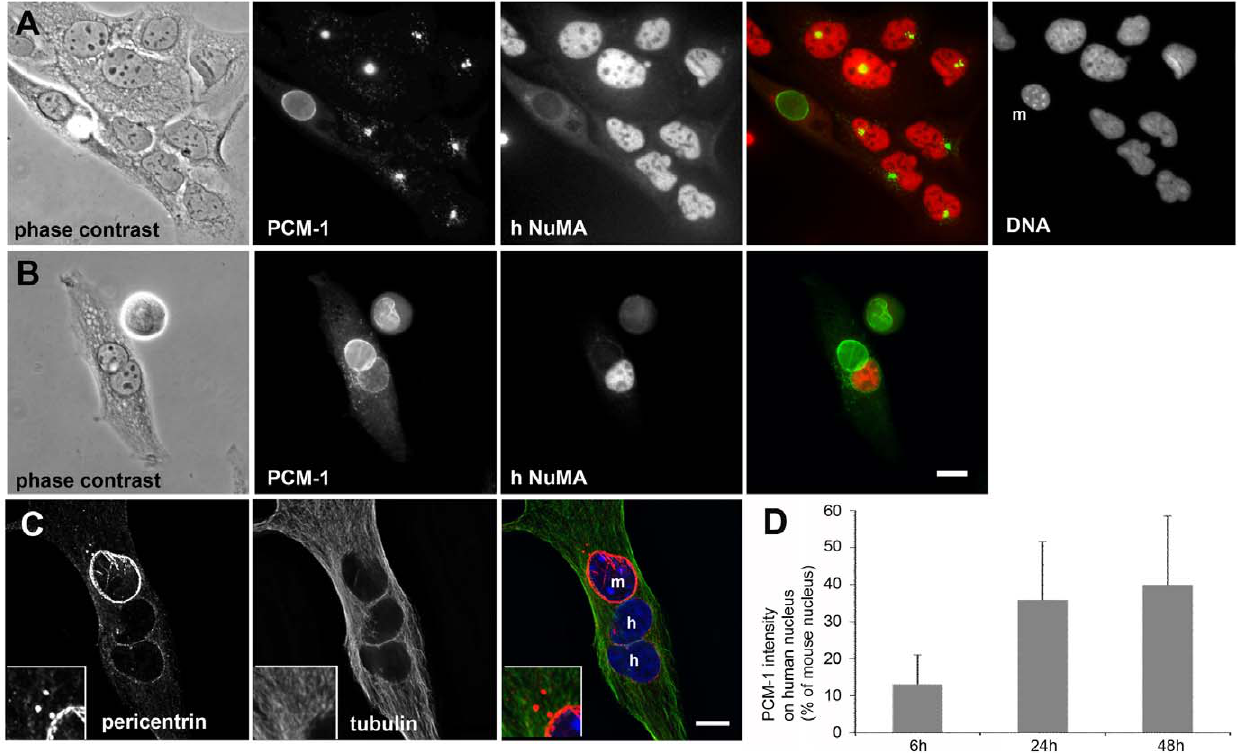
Figure 4. Centrosome proteins are recruited to the nuclear surface of non-muscle cells, after fusion with differentiated muscle cells. (A) Co-culture of H-2K b -tsA58 mouse muscle cells with human U2OS cells. Top left: phase contrast; top middle: immunofluorescence of the centrosome protein PCM-1; top right: staining of the DNA with DAPI; bottom left: immunofluorescence of the human form of the nuclear protein NuMA; bottom right: merge of PCM-1 (green) and NuMA (red) staining. Note that NuMA staining is exclusively visible in nuclei of the human U2OS cells. Mouse nuclei (m) show characteristic condensation of heterochromatin in discrete nucleoplasmic punctuate staining that is absent from the surrounding human nuclei. (B) Heterokaryon, formed by fusion of a human U2OS cell with a mouse H-2K b -tsA58 cell. A cell is shown at 48 hours after induction of fusion with polyethylene glycol. Staining and microscopy as in (A). The human nucleus, as identified by NuMA immunofluorescence, shows accumulation of perinuclear PCM-1. (C) Heterokaryon, 6 hours after induction of fusion, stained for pericentrin (red), tubulin (green), and DNA (blue). ‘‘m’’ and ‘‘h’’ indicate the nuclei contributed from the mouse H-2K b -tsA58 cell, or from the human U2OS cells, respectively. Insets show an enlarged area of the cytoplasm, containing remnants of the centrosomes. (D) Histograms, showing PCM-1 intensity at human nuclei in heterokaryons, as a percentage of PCM-1 immunofluorescence levels around mouse nuclei from the same heterokaryon (6 h: n=20; 24 h: n=45; 48 h: n=22). Bars in (B), (C), 10 m